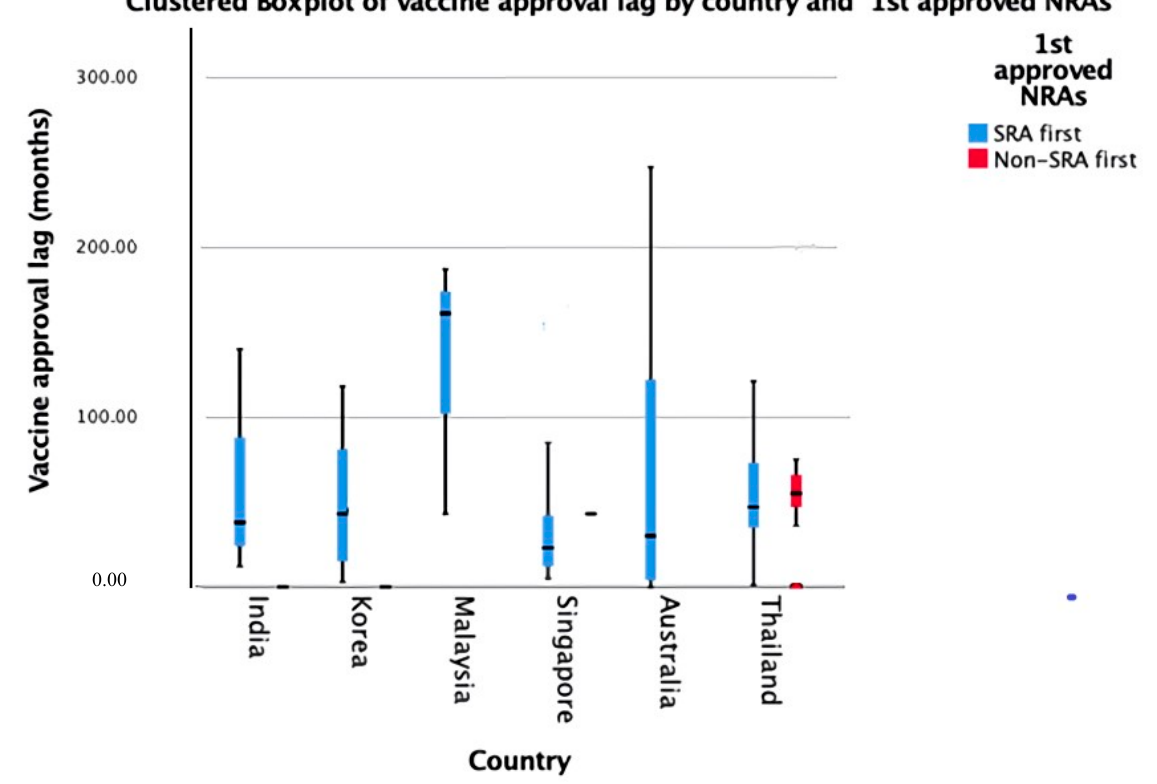
Figure 3. Boxplot of vaccine relative approval lag divided by the first approval national regulatory agencies .